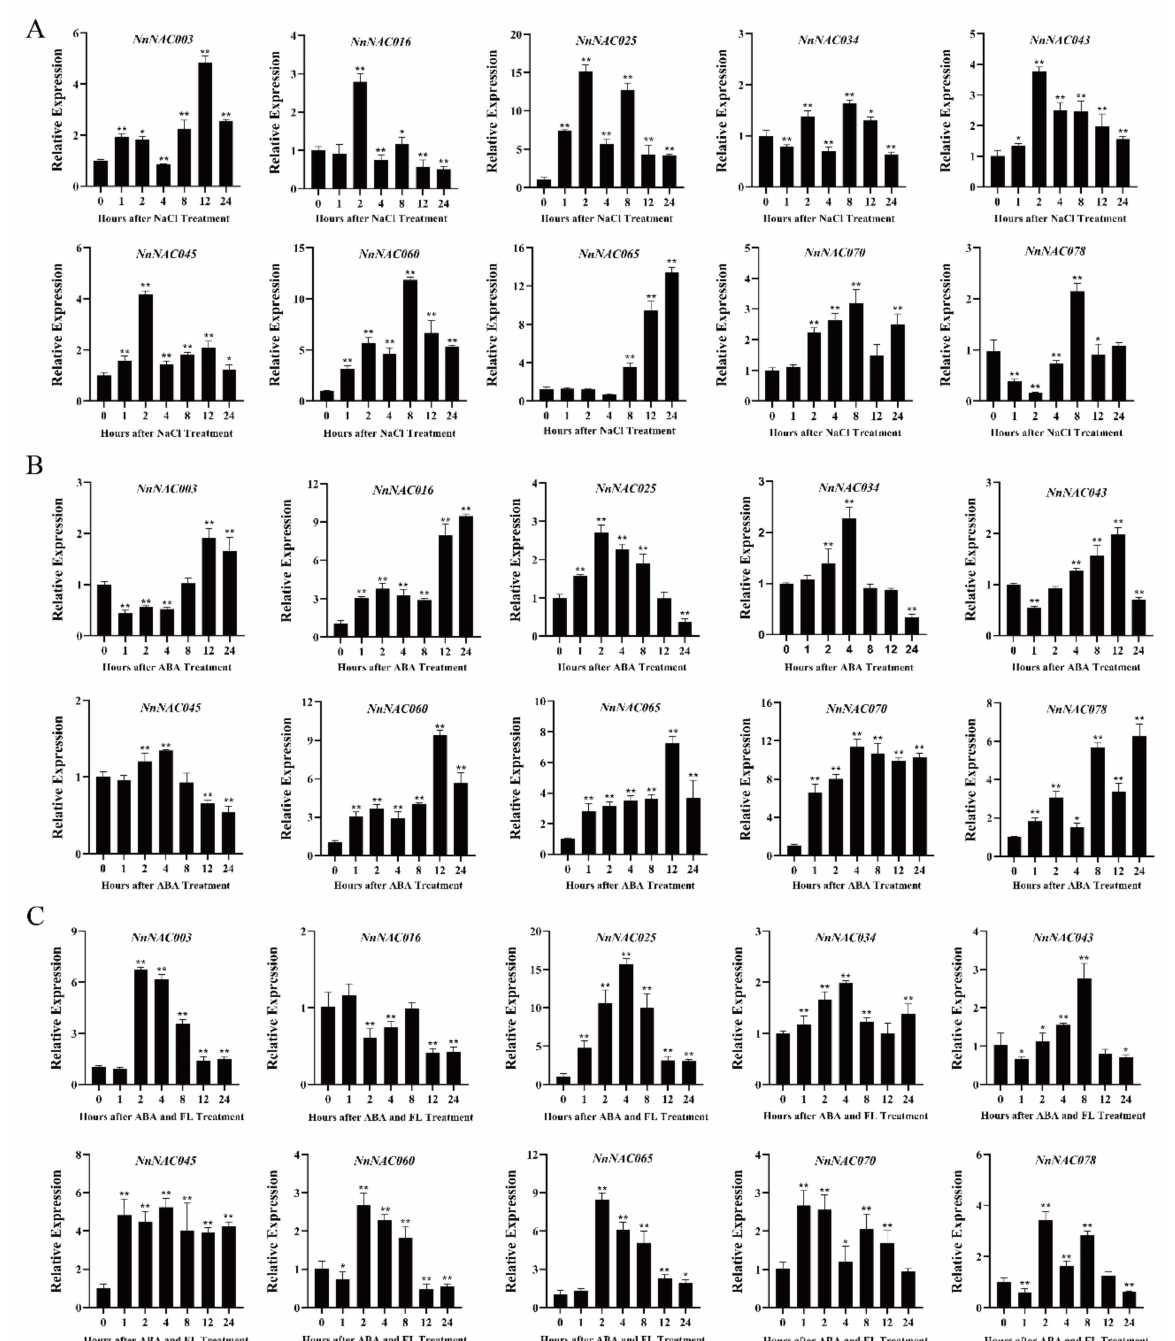
Figure 5. Relative expression levels of lotus NAC genes. qRT-PCR analyses of plants treated with NaCl ( A ), ABA ( B ), and ABA + FL ( C ). Independent t -tests demonstrated that there was significant difference (* p <0.05, ** p <